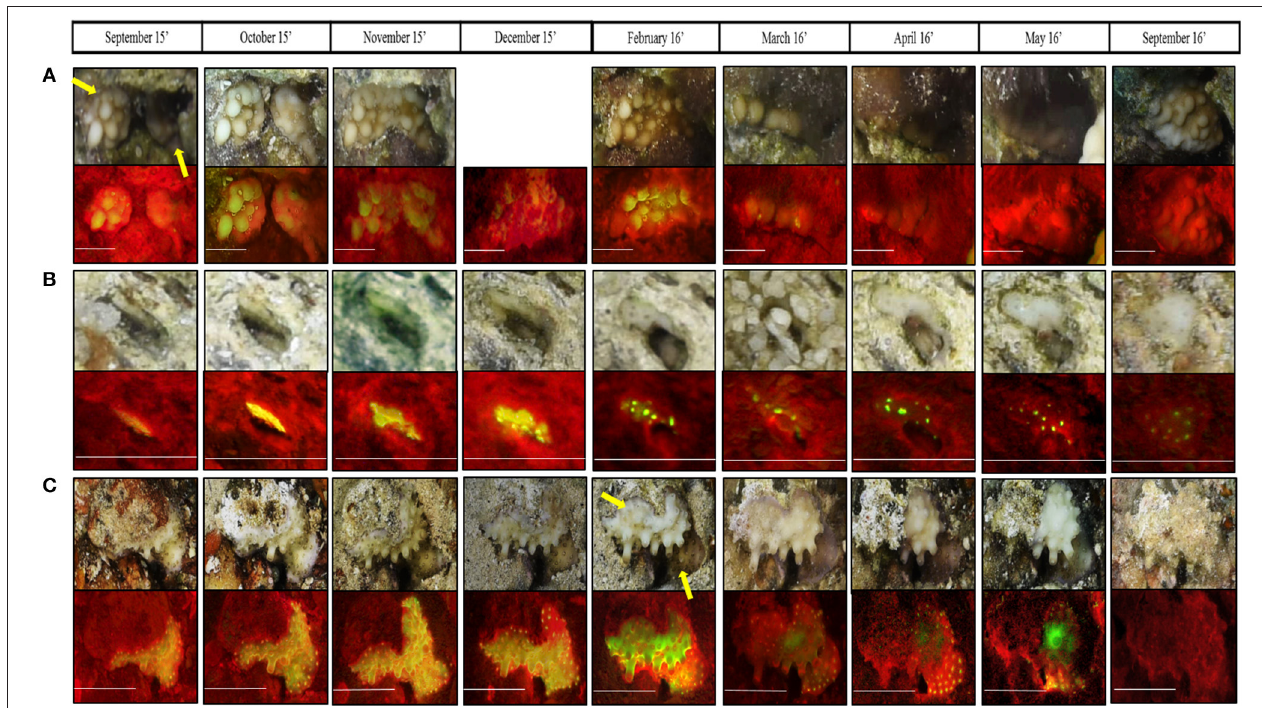
FIGURE 7 | Magnification of three phenomena recorded both in fluorescence and reflectance imaging during the present surveys; (A) Two Montipora verrucosa recruits fused to one colony from November 2015, (B) the growth of Porites sp. in 0.036cm 2 during the survey period, and (C) competition between Porites sp. (botom coral) to Echinopora tiranesis (top coral). All scale bars are 0.5cm. In (A) December 2015 reflectance image is missing since the camera moved while imaging so the coral was cutout of the